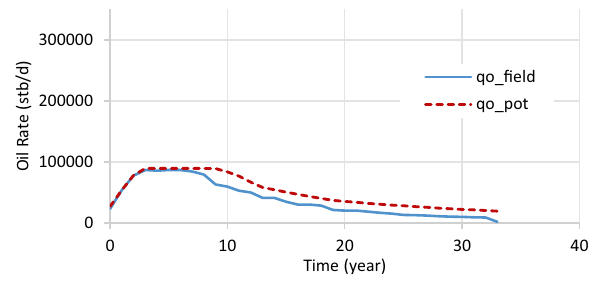
Fig. 22 Optimum oil production profile and oil production potential for strategy Tie-back with GL + WI